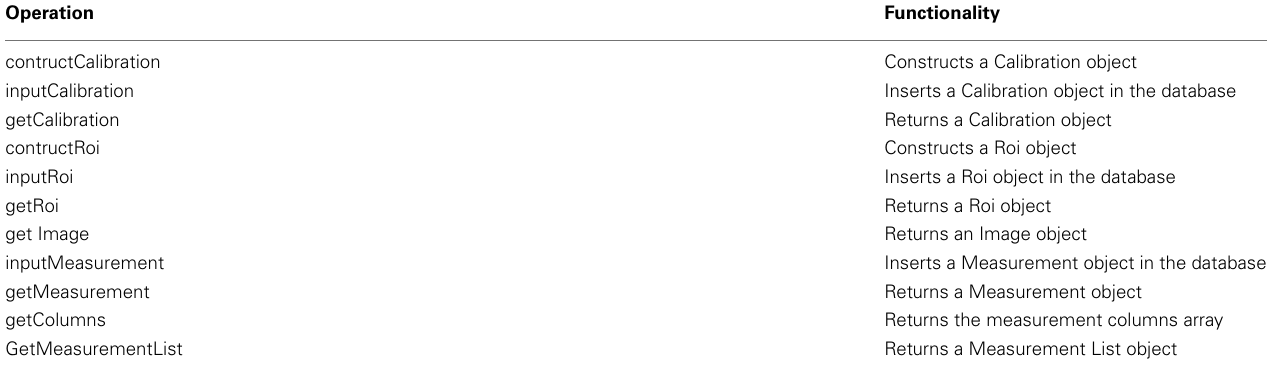
TableA2 | Main operations and